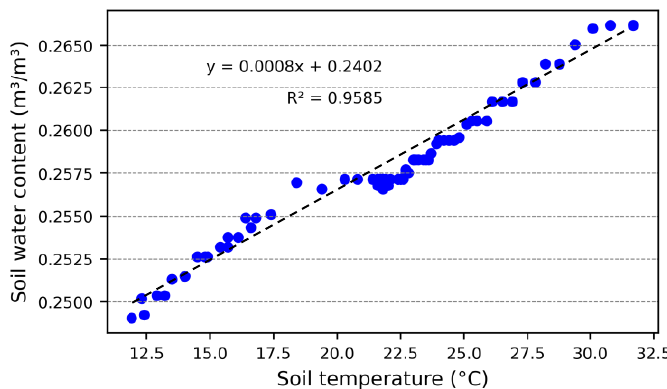
Figure 10. Sensor response under temperature